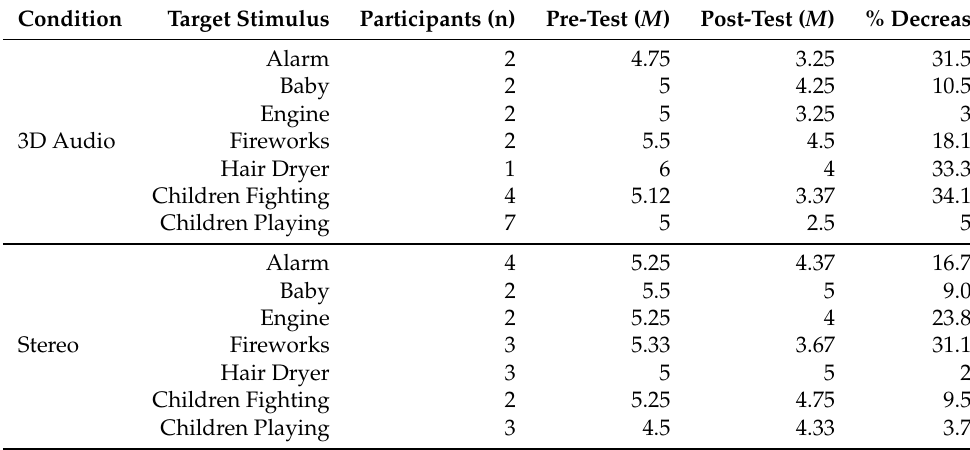
Table 2. Changes in mean self-reported anxiety scores for target stimuli across both experimental conditions, showing pre and post measurement scores with percentage